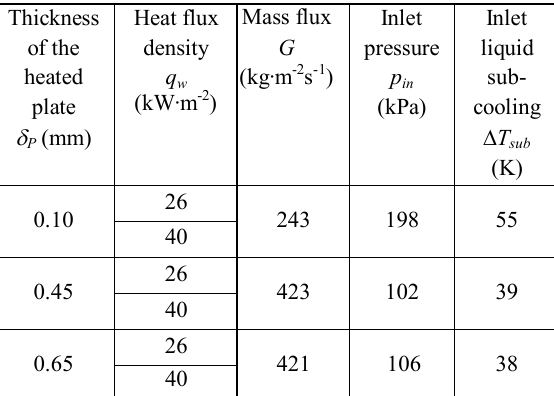
Table 2. Experimental parameters of tested